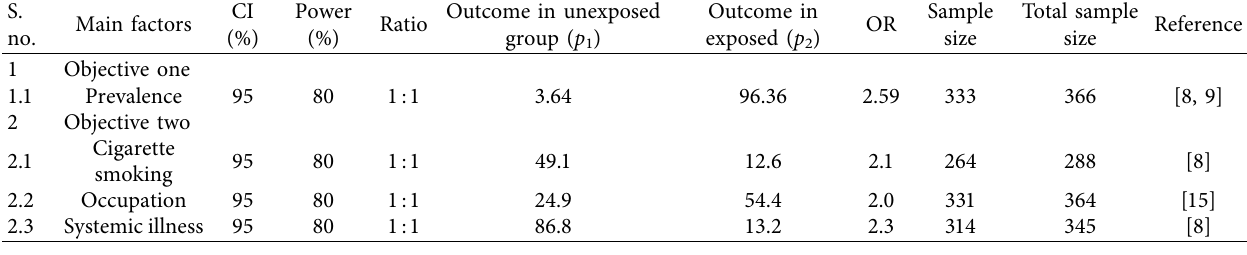
Table 1: Sample size determination for associated risk factors of cataract among adult people aged 40 years and above in South Ari district, Southern Ethiopia, 2021.